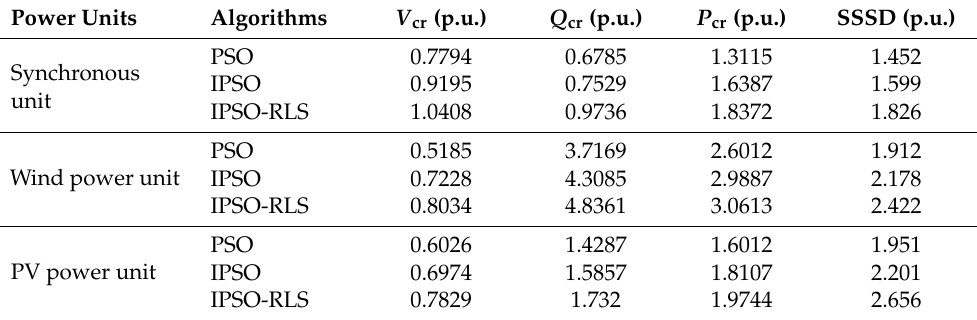
Table 4. Comparison of SSSR surface parameters of different algorithms for three units.